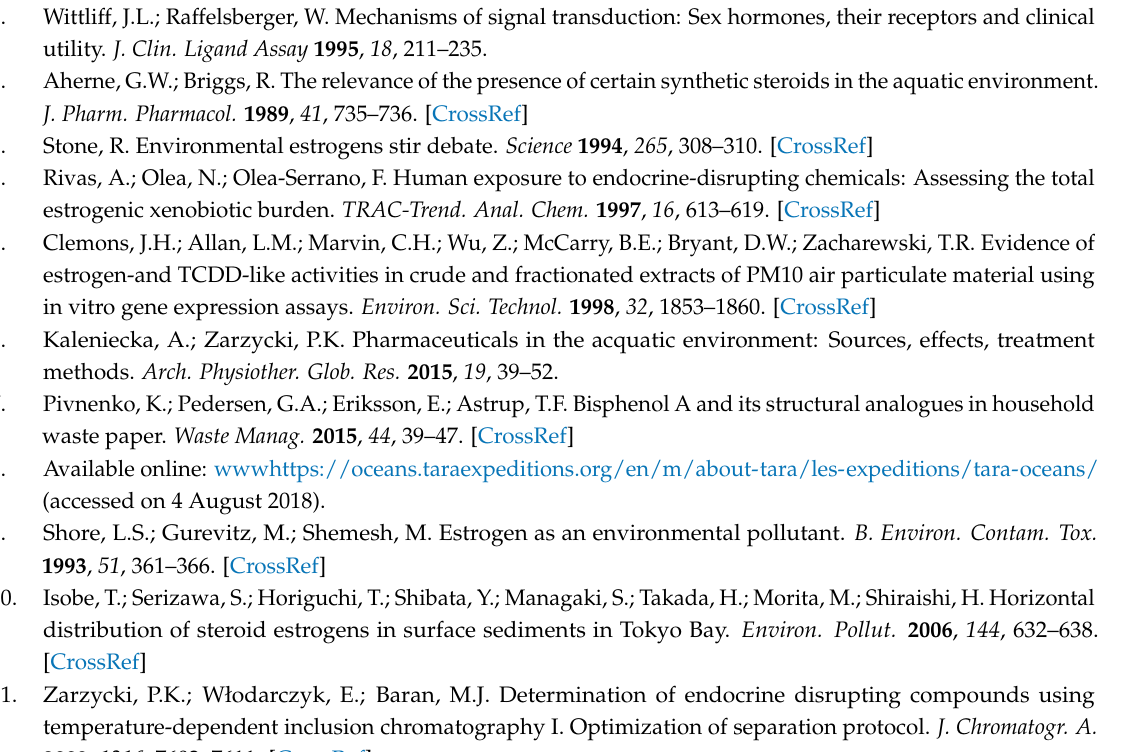
Supplementary Materials: The following are available online. Figure S1: Chemical structures of selected bisphenols and internal standard substance (7,8-dimethoxyflavone) for chromatographic analysis of target analytes. Figure S2: HPLC chromatograms of SPE extracts of environmental samples and recorded at analytical wavelength = 280 nm. Figure S3: Geographical location and bathymetric intersection through “Jezioro Morskie Oko” lobelia